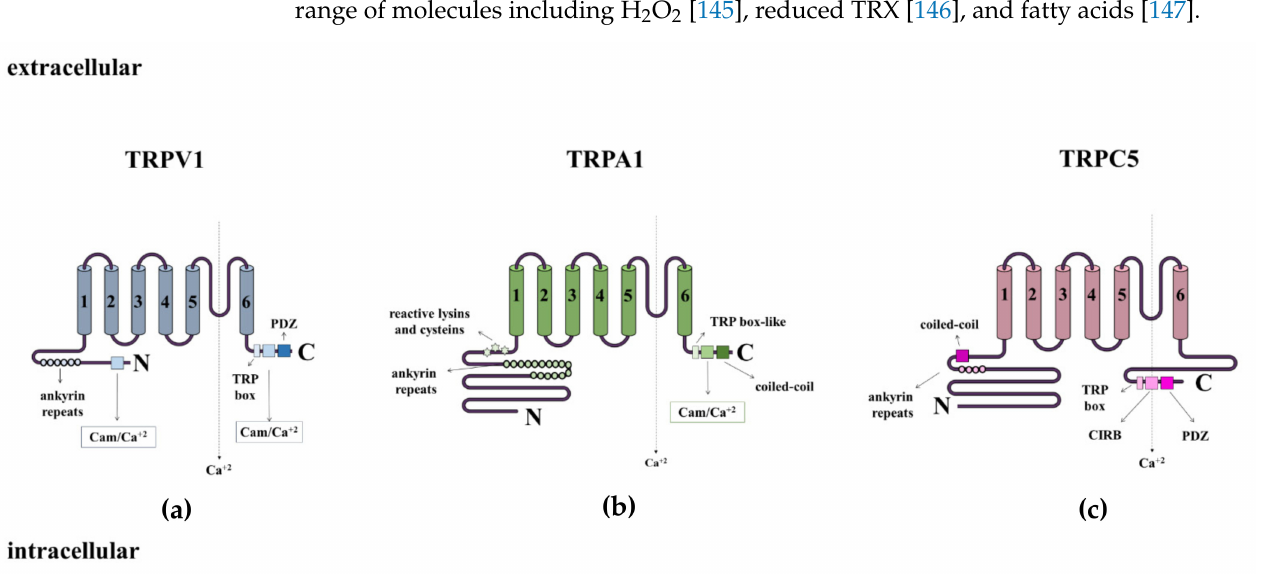
Figure 3. TRPV1, TRPA1 and TRPC5 structures. ( a ) TRPV1, ( b ) TRPA1 and ( c ) TRPC5 structures are composed of different domains including six transmembrane domains with a pore region, N and C- terminus, ankyrin repeats, coiled-coil, calmodulin (CaM)/Ca 2+ -binding region, TRP-box, calmodulin (CaM)/inositol 1,4,5-trisphosphate (IP 3 ) receptor binding (CIRB), and PDZ domains. The roles of TRPV1, TRPA1 and TRPC5 as mediators of oxidative stress and inflamma- tion and, as modulators of MS are discussed